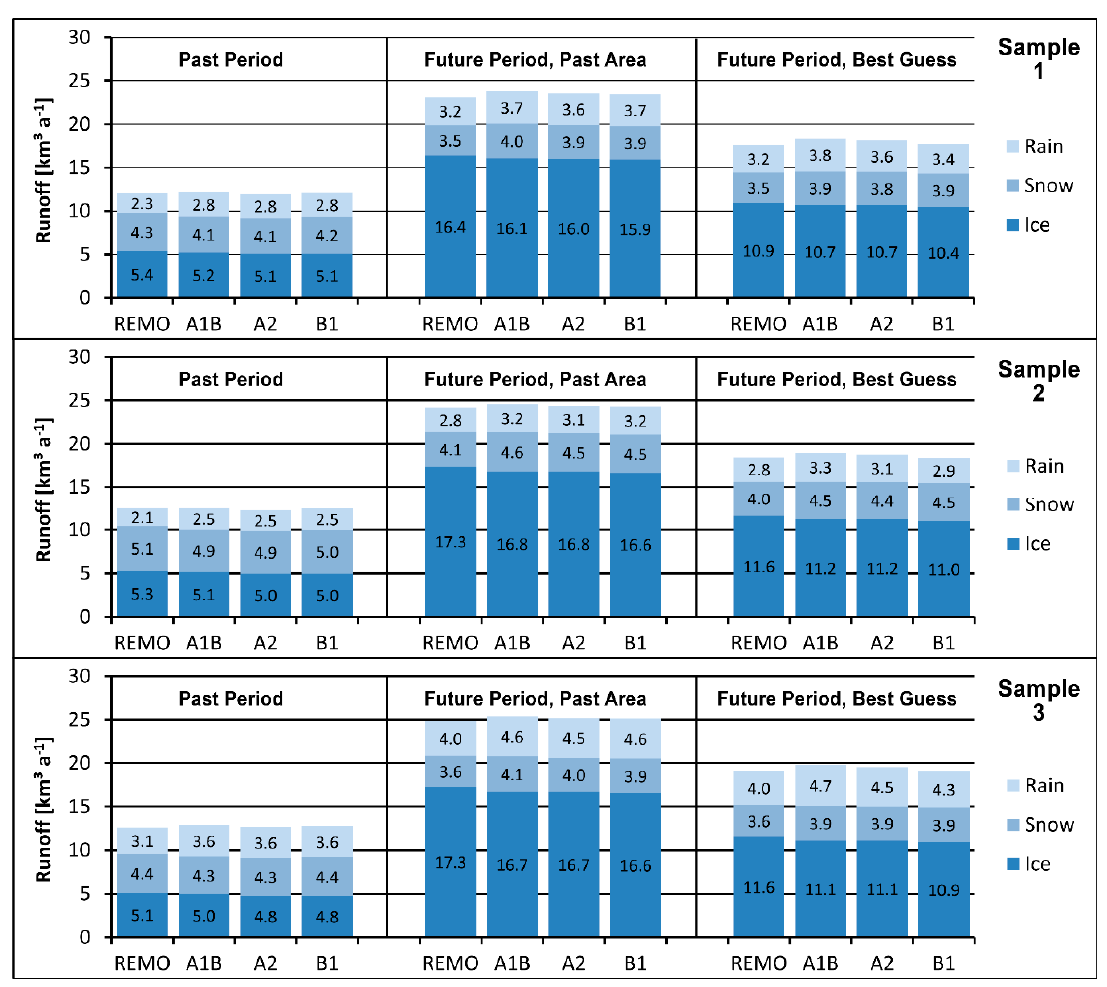
Figure 7. Runoff divided into its components rain, snow and ice.